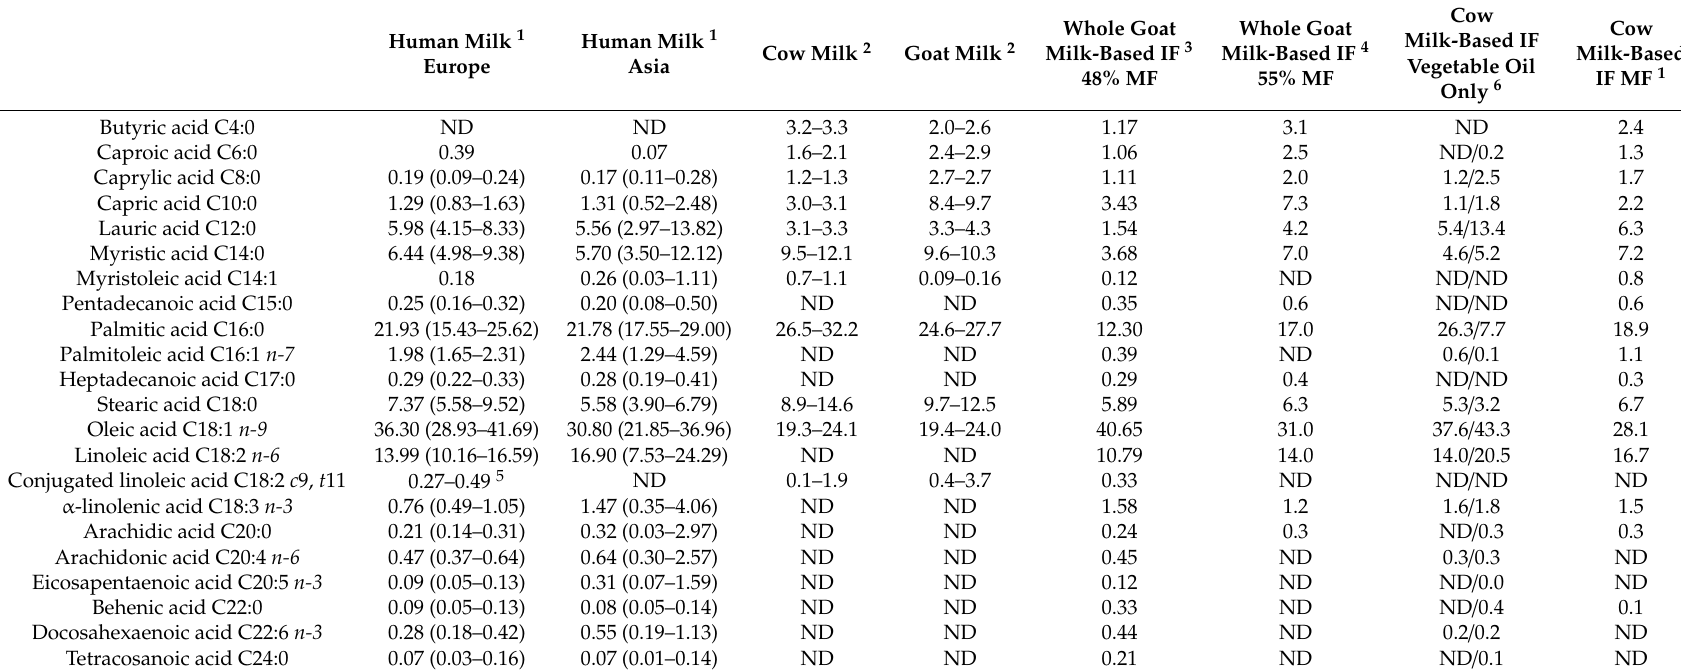
Table 1. Fatty acid concentration (% of total fatty acids) in human milk, cow milk, goat milk and whole goat milk-based infant formula. Human Milk